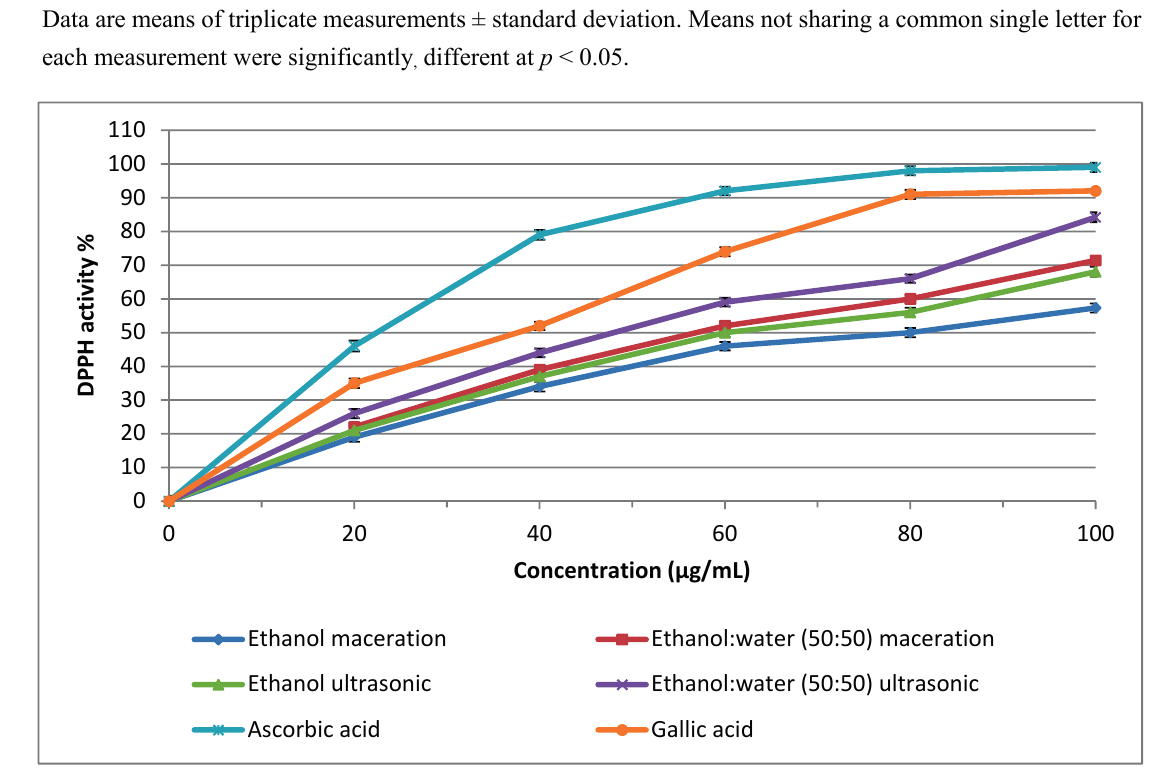
ging activity (DP .